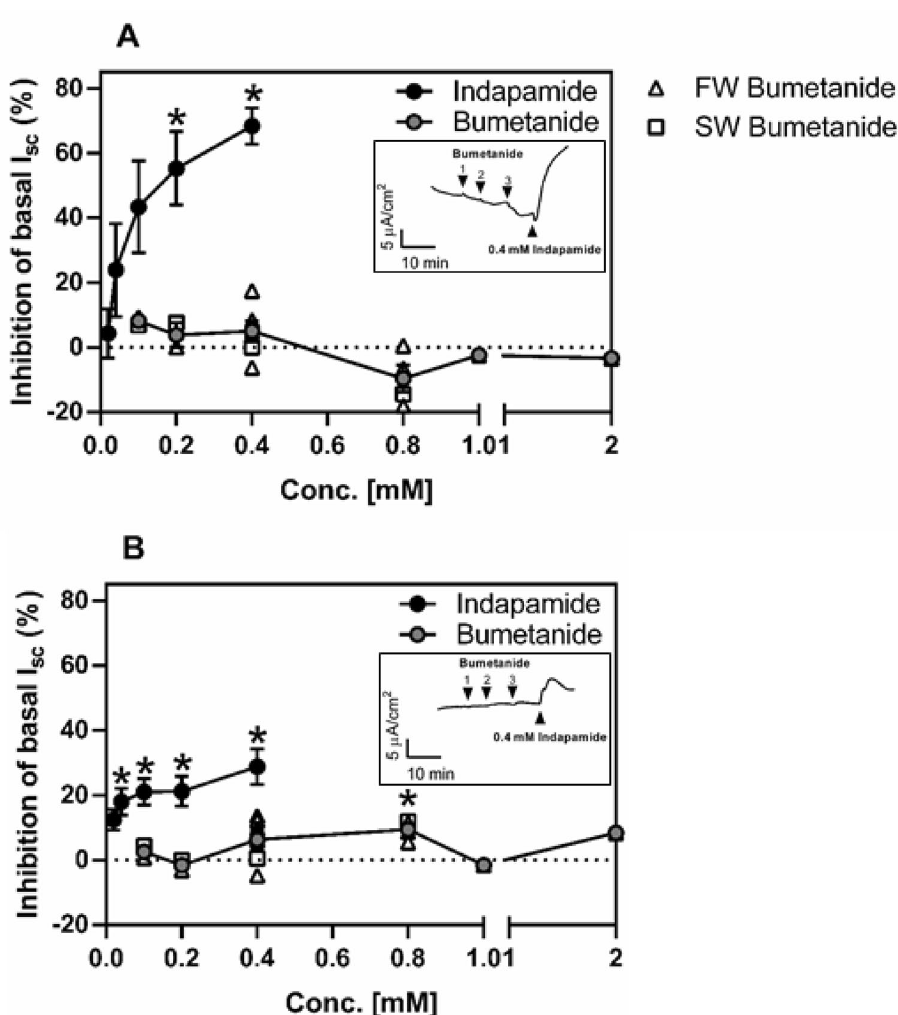
Figure 5. Impact of increasing concentrations of bumetanide or indapamide on basal short circuit current (I sc , μA cm −2 ) in the anterior (AI; A ) or posterior (PI; B ) intestine of juvenile sea lamprey acclimated to FW and/or SW. After mounting the tissues, the I sc was allowed to stabilize ( i.e ., baseline level) before adding the respective inhibitors. Note, the grey circles represent the mean response of intestinal tissues of FW-acclimated (open triangles) and SW-acclimated (open squares) sea lamprey at each concentration of bumetanide tested. In contrast, the effect of increasing concentrations of indapamide were only examined in intestinal tissues of SW-acclimated sea lamprey. The inset figures are examples of the impact on the I sc of a single application of indapamide (0.4 mM) following the last 0.4 mM bumetanide application. Data are the mean ± SEM (n = 2–6). *Significant differences between the basal I sc and the I sc after it reached its maximal change following drug application at each concentration of drug tested (one-sample